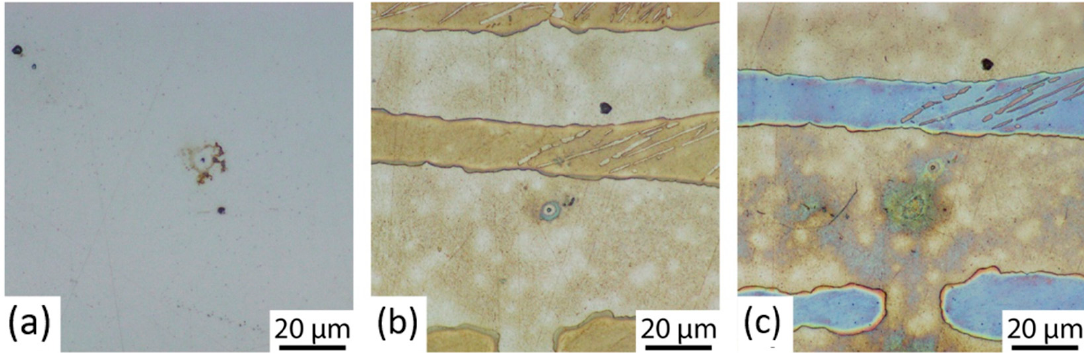
Figure 9. Corrosion pit, 6Al-4Mn-HT steel; ( a ) 5 min ( b ) 1 h, ( c ) 3 h immersion (3.5% NaCl).